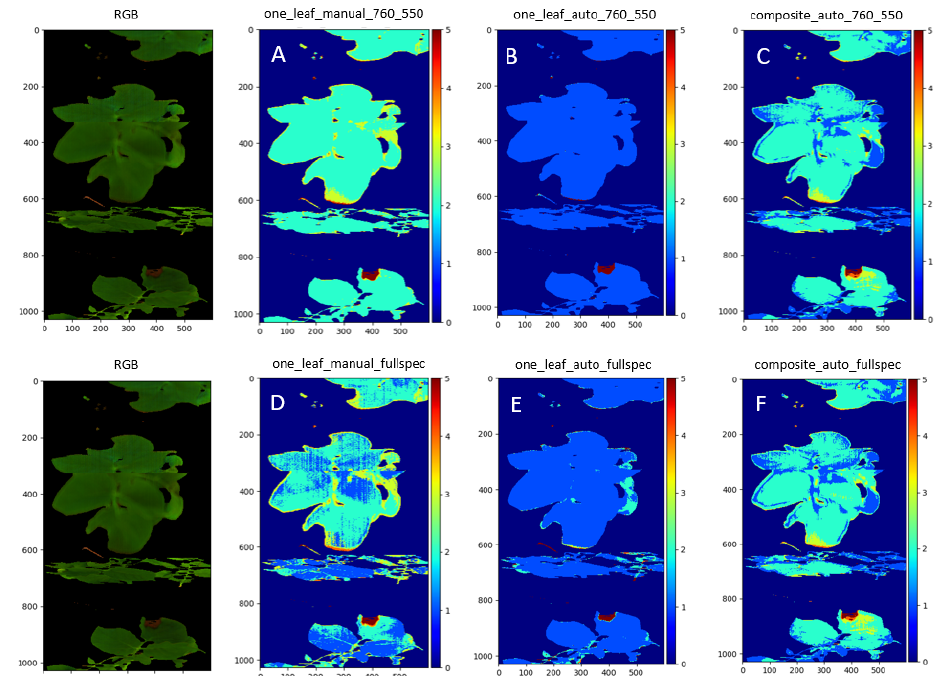
manual and automatic models, respectively. The color bar represents the label given by the automatic labelling algorithm.